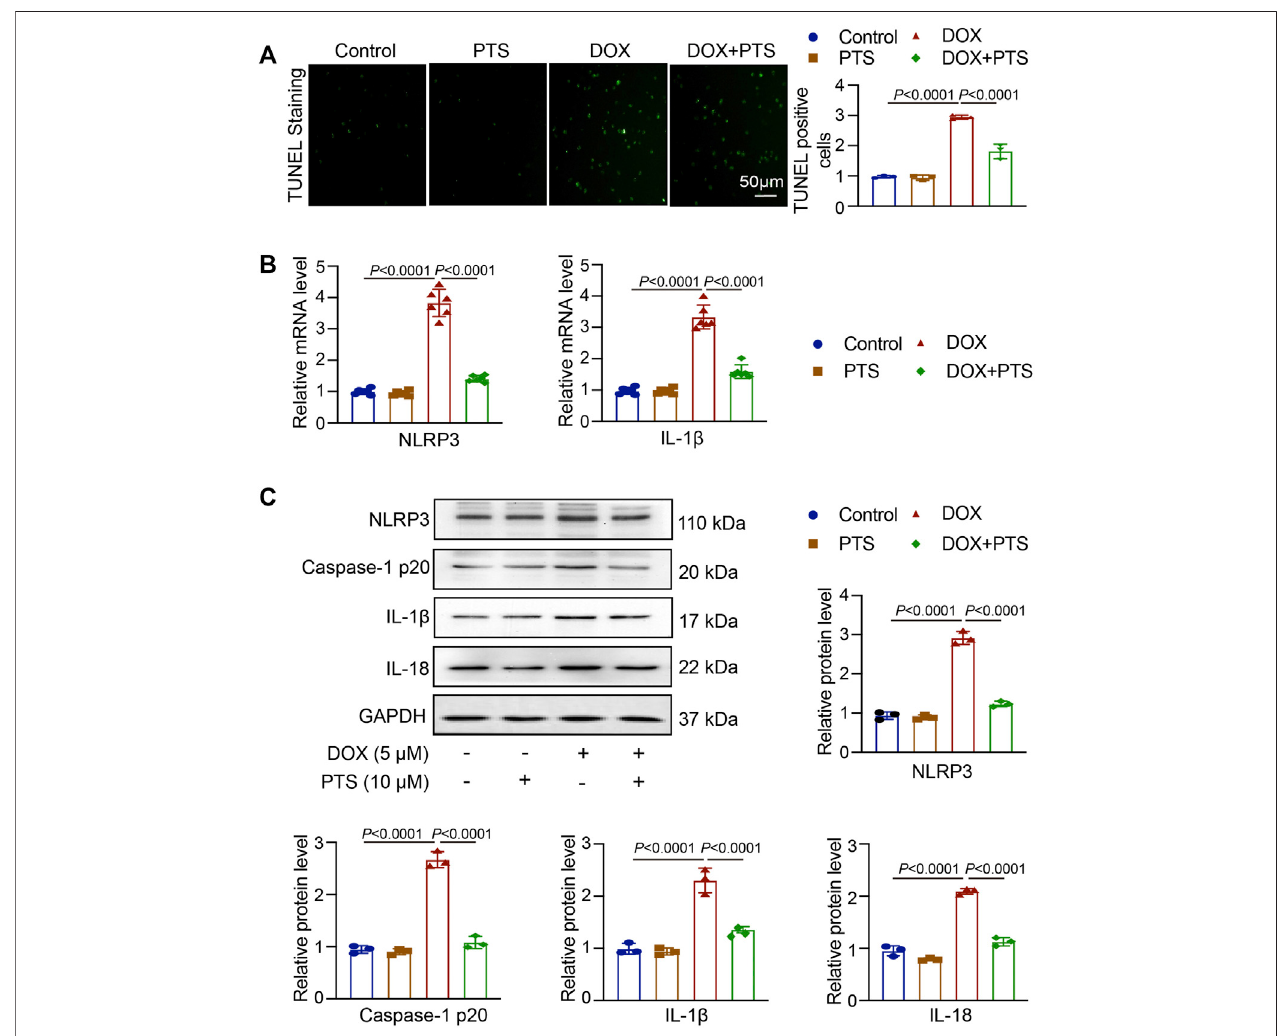
FIGURE 6 | PTS effects on NLRP3 in fl ammasome expression in DOX-treated HepG2 cells. (A) HepG2 cells were pretreated with PTS (10 μ M) for 4 h and afterwards with DOX (5 μ M) for 24 h. The cells were analyzed by TUNEL staining to detect apoptosis in DOX-treated HepG2 cells and the protective effects of PTS against DOX-induced apoptosis (left), relative quanti fi cation of TUNEL positive cells (right, n = 3); (B) PTS effects on NLRP3 and IL-1 β mRNA levels in DOX-treated HepG2 cells ( n = 6); (C) PTS effects on NLRP3, IL-1 β , and IL-18 protein expression in DOX-treated HepG2 cells ( n = 3); quanti fi cation of NLRP3, IL-1 β , and IL-18 protein expressions ( n =